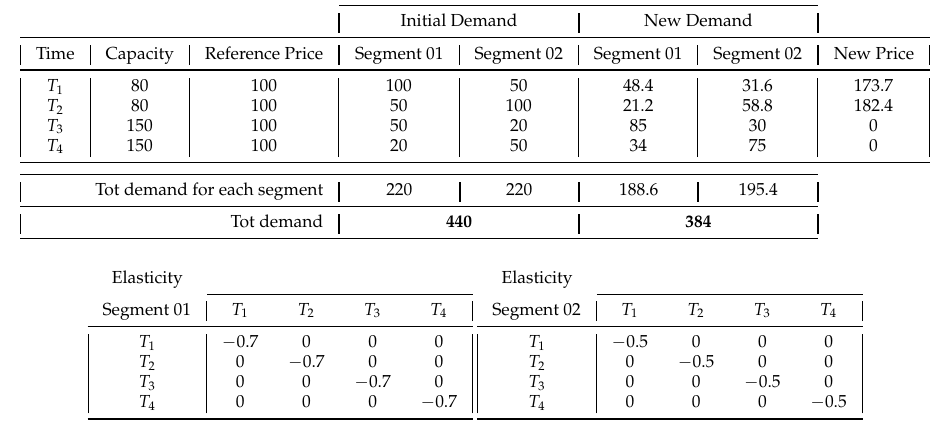
Table 5. Case Study 6.01—fourth sub-case, data, and results.